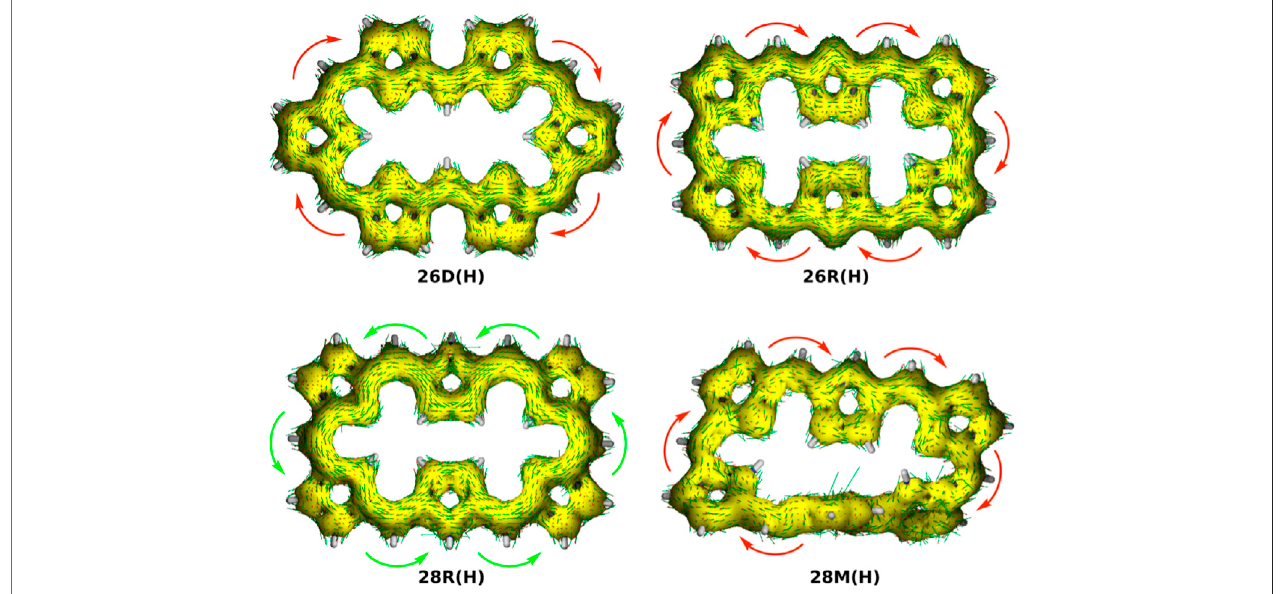
FIGURE3 | AICD isosurface plots(isocontourvalue0.05) ofunsubstituted [26]and [28]hexaphyrins withdifferentconformations computed at the CAM-B3LYP/6- 311+G(d,p) level of theory. The arrows denote the direction of the current density vectors.